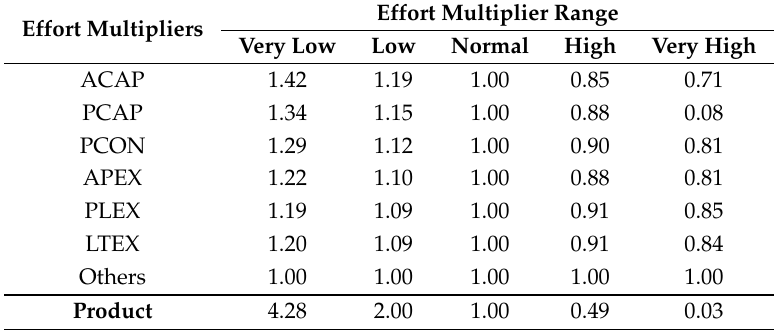
Table 5. COCOMO Effort Multipliers.